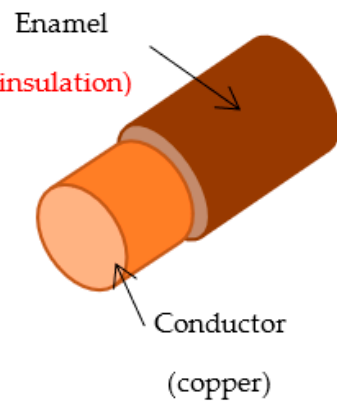
Figure 1. Illustration of an enameled wire.